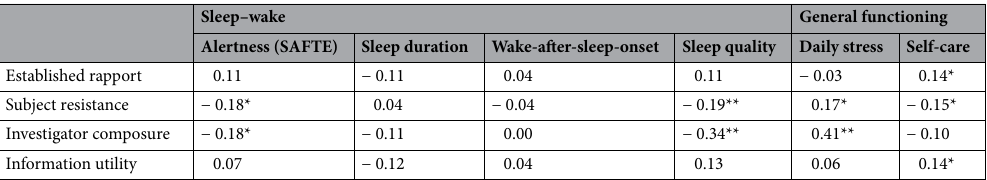
Table 3. Associations between daily interview outcomes and daily functioning (N = 168–204 days). Pearson’s correlations across investigator-days. *p < 0.05; **p < 0.01.